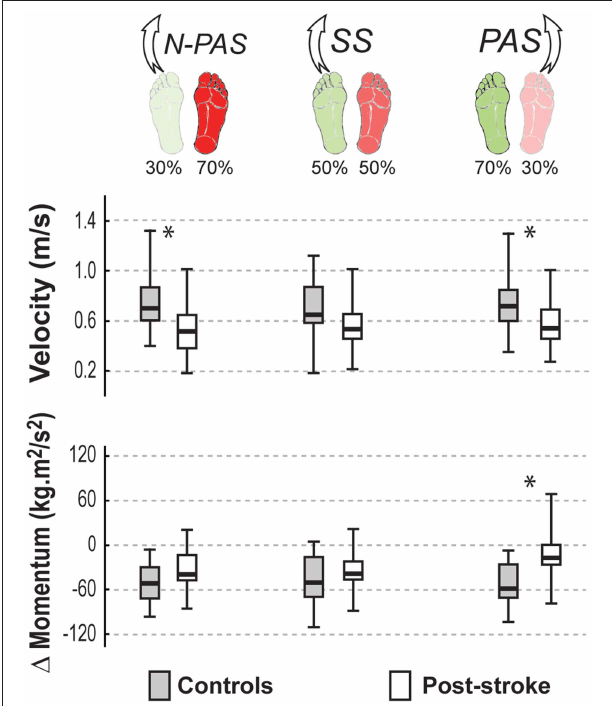
FIGURE 6 | Landing characteristics by group. The median (thick line) of the landing characteristics is presented for each group and each condition in which they were compared. Boxes represent 25 and 75th percentile. Bars represent min and max values. *Indicates a difference between groups at p <